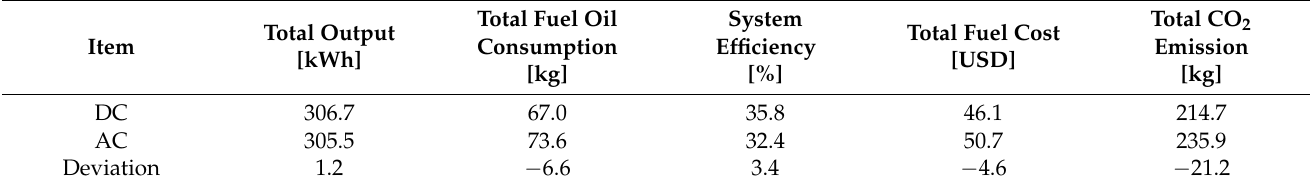
Table 7. The comparison results of the total output, total fuel oil consumption, system efficiency, total fuel oil cost, and the total CO 2 emissions for 5,500 TEU in the AC and DC distribution systems.